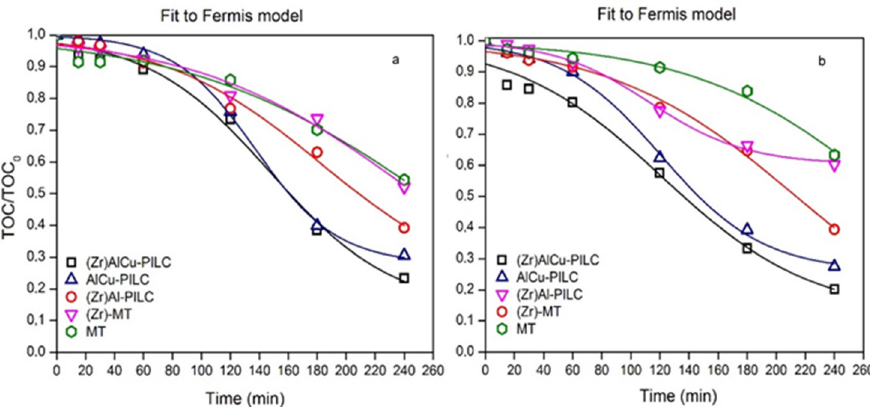
Figure 5. Normalized TOC content (TOC/TOC 0 ) as a function of time, using different pH conditions: ( a ) pH 4, ( b ) pH 7 (catalyst dosage = 3.0 g/L, [H 2 O 2 ] 0 = 98 mM, [TOC] 0 = 500 mg C/L). Fit of Fermi’s equation based on lumped kinetic model to the experimental data.